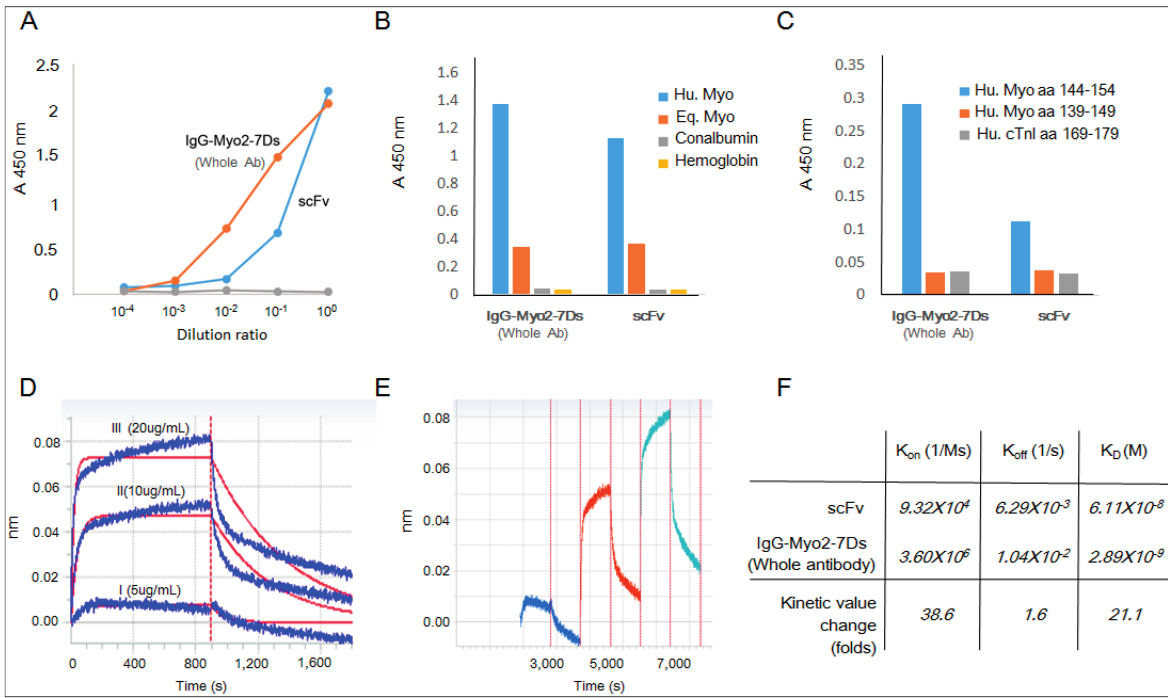
Figure 6. Binding analysis of the refolded scFv fragment. ( A ) Enzyme-linked immunosorbent assay (ELISA) analysis for the binding of scFv on the human myoglobin coated surface. Serial dilutions (×1/10) were made for the premature antibody and the refolded fragment with an initial concentration of 0.1 and 30 μ g/mL, respectively; ( B ) Comparative ELISA analysis of the refolded scFv and the whole antibody for human myoglobin, equine myoglobin, conalbumin and hemoglobin (scFv 1.9 μ g/mL, IgG2-7Ds 0.5 μ g/mL); ( C ) Comparative ELISA analysis of the refolded scFv and the whole antibody for synthetic peptides of human myoglobin and human cardiac troponin I (scFv 1.9 μ g/mL,